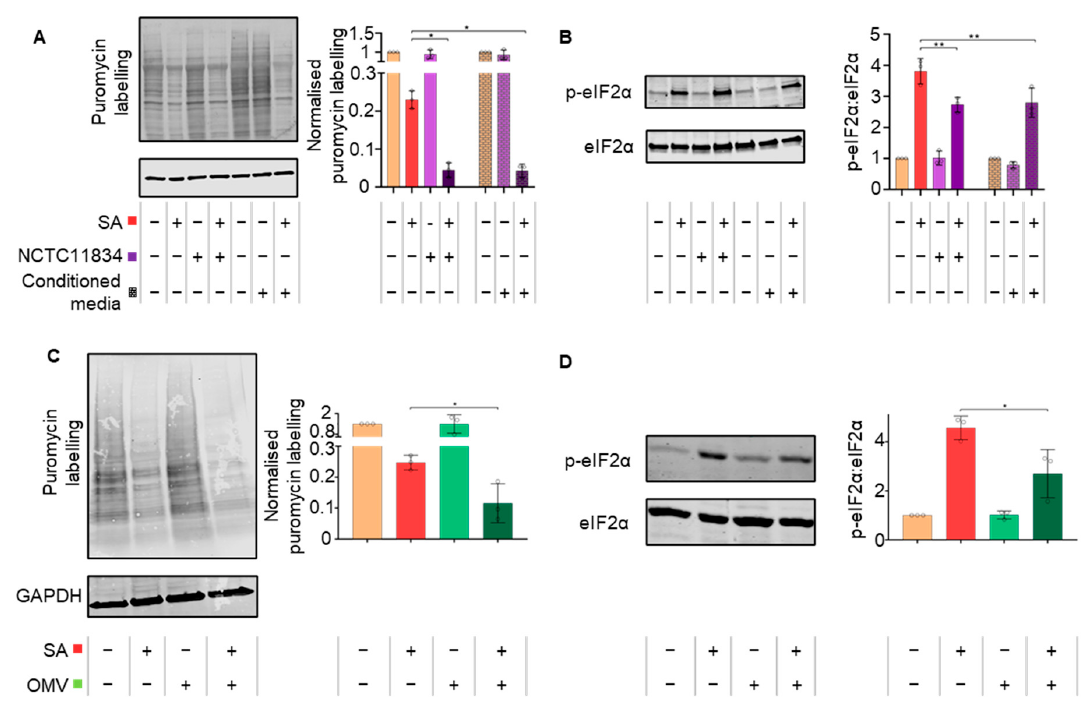
Figure 4. P. gingivalis heightens translational repression via the action of a secretory factor. ( A ) Relative rate of protein synthesis as determined by puromycin uptake (left) and quantification relative to GAPDH (right), when H357 cells were treated with filtered conditioned media recovered from cells previously treated with P. gingivalis (NCTC11834, MOI of 100, t = 2 h) in the presence or absence of sodium arsenite. ( B ) Levels of phosphorylated eIF2 α (left) and concentration of phosphorylated to total eIF2 α (right) when probed using immunoblotting (mean ± SD, n = 3). ( C ) H357 cells were challenged with purified P. gingivalis (NCTC11834) OMV vesicles (100 µ g/mL, t = 2 h) with or without sodium arsenite for the final 30 min and the relative rate of protein synthesis measured by puromycin uptake (left) and concentration relative to GAPDH (right) and ( D ) the levels of phosphorylated eIF2 α (left) and the concentration of phosphorylated to total eIF2 α (right) with OMVs were probed using immunoblotting (mean ± SD, n = 3). **, p ≤ 0.01; *, p ≤ 0.05 according to Kruskal–Wallis